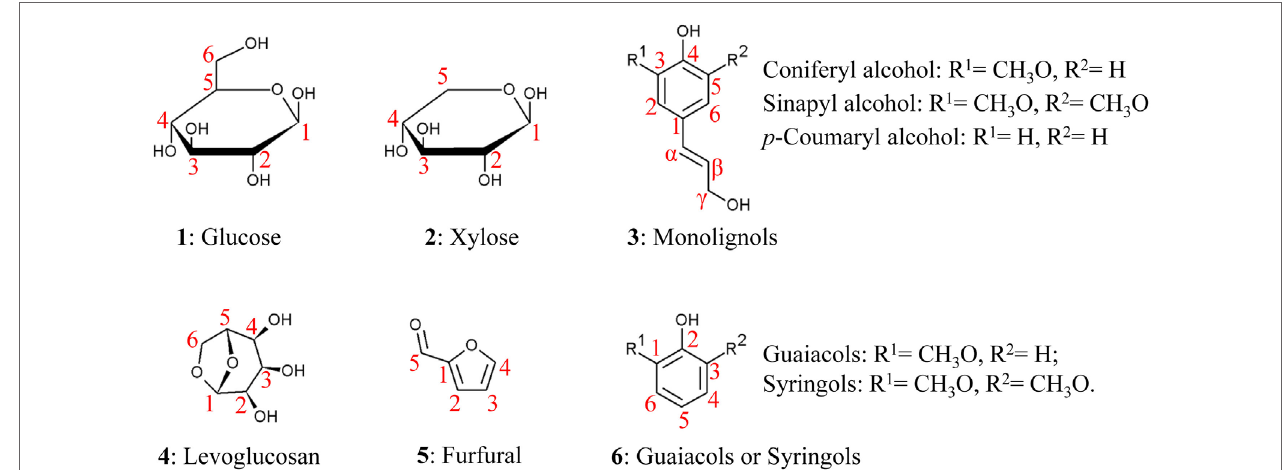
FiGURe 1 | Chemical structure of the major basic units of biomass polymers and related products .